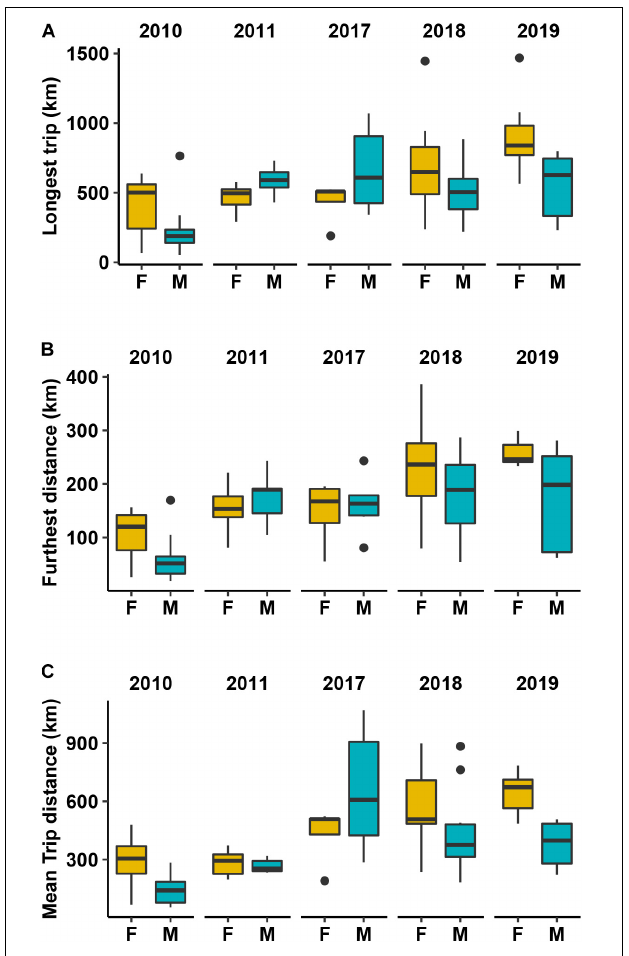
FIGURE 4 | Movement descriptors showing the: (A) longest trip (km), (B) furthest distance travelled from the colony (km) and (C) mean trip distance (km) per individual. Orange, females; blue, males. Black horizontal line depicts the median value.